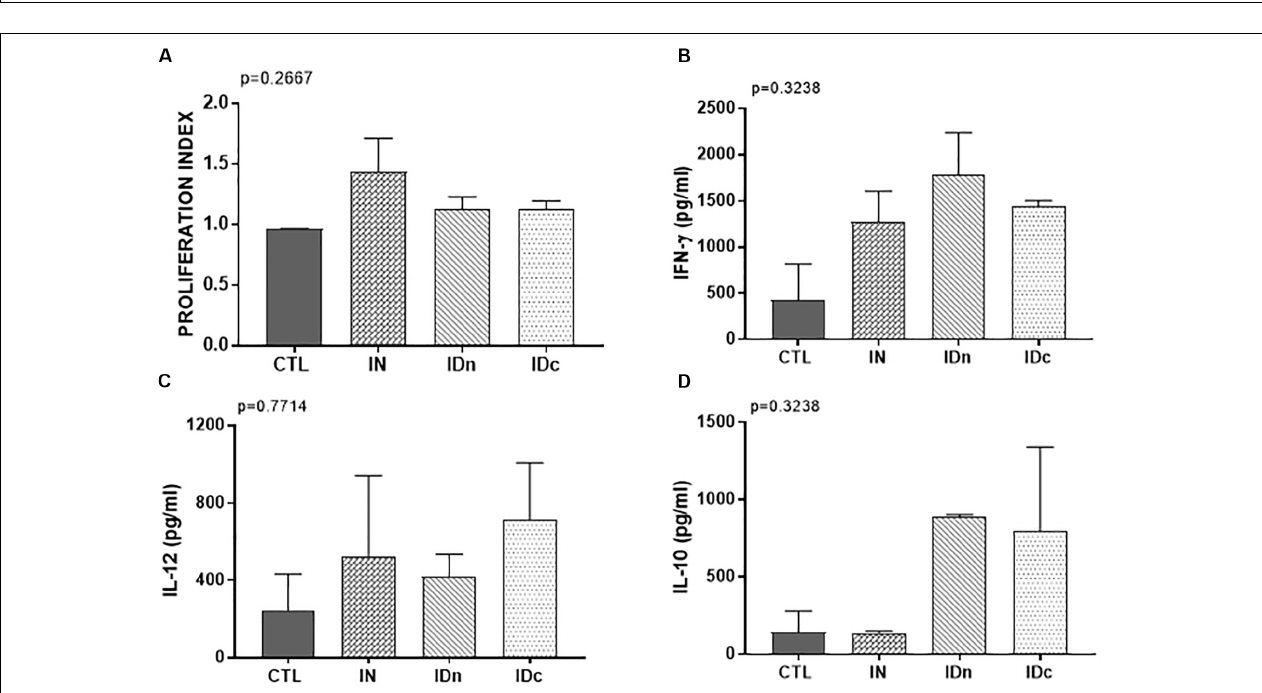
FIGURE 6 | Expression of immune markers of splenocytes from sheep (2 per group) 6 months after the last vaccination in the latent toxoplasmosis experiment. Splenocytes were isolated and stained for the immune markers MHCII, CD4, CD14, DU204, CD11b, CD8, and CD11c. CTL: inoculated with DGNP alone as control; IN: vaccinated by nasal route; IDn: vaccinated by intradermal route in the neck area; and IDc: vaccinated by intradermal route in the cheek area. Data are expressed as mean ± SEM.